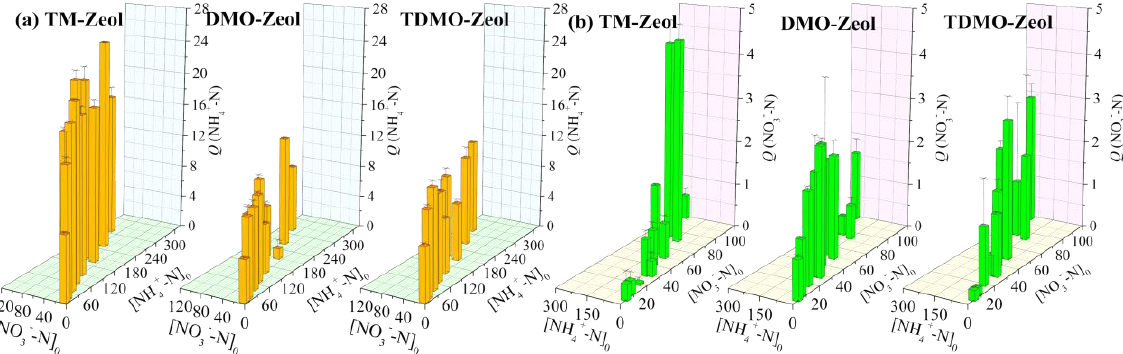
Figure 8. Influence of initial concentration on the adsorption of ( a ) NH 4+ − N and ( b ) NO 3 − − N using grafted Zeol.